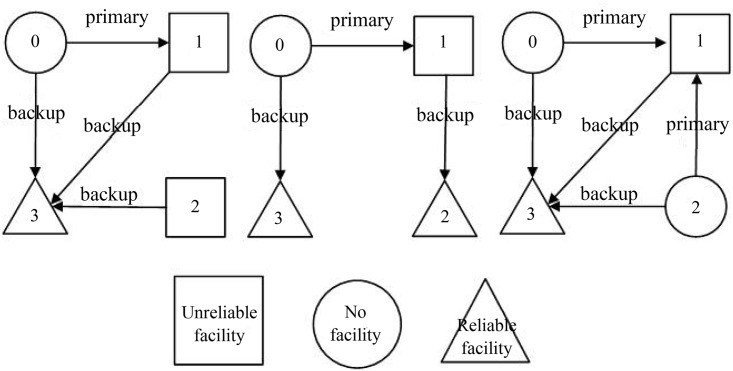
Illustrative example for the local moves.